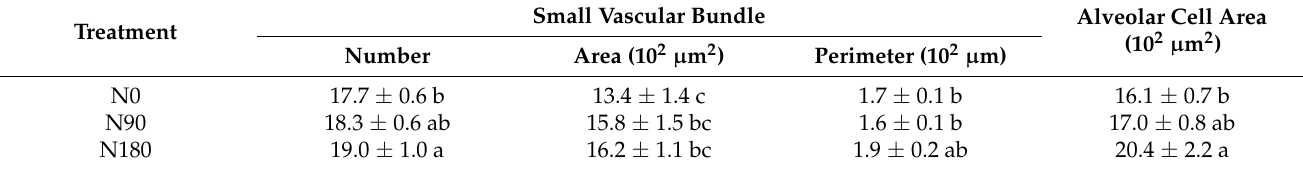
Figure 3. Effects of N application rates on rice leaves anatomical structure at heading and flowering stage. ( a ) Photo of rice leaves; ( b ) paraffin sections of rice leaves (20 × ); ( c ) paraffin sections of rice leaves (40 × ). Table 2. Effects of N application rates on morphological parameters of rice